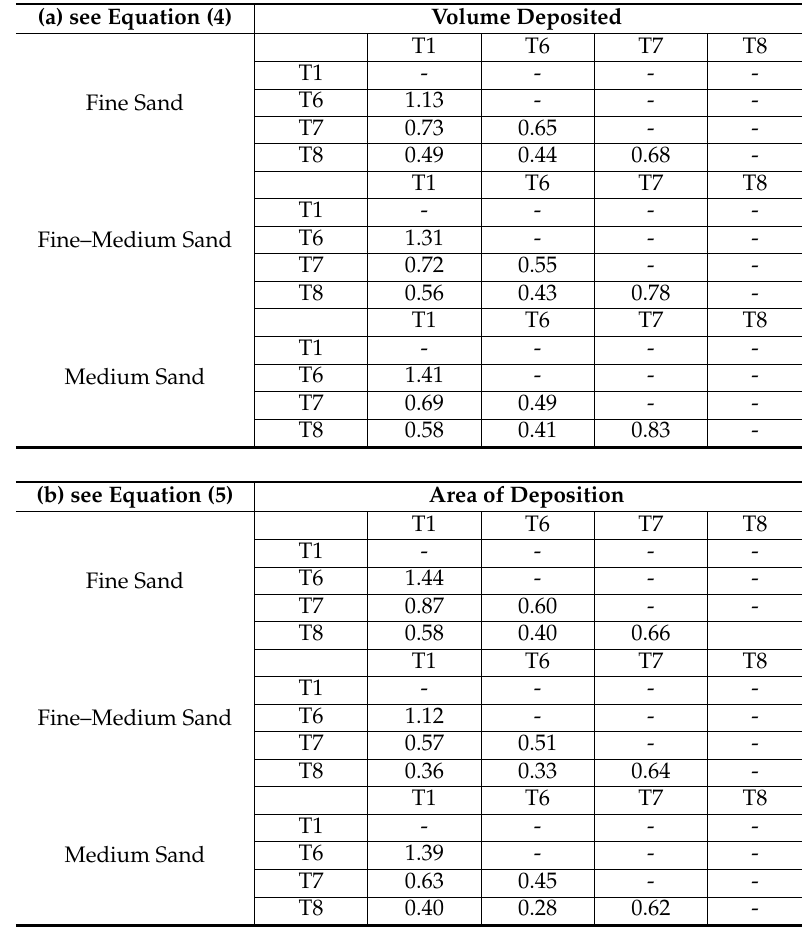
Table 7. Ratios for (a) M factor2 and (b) M factor3